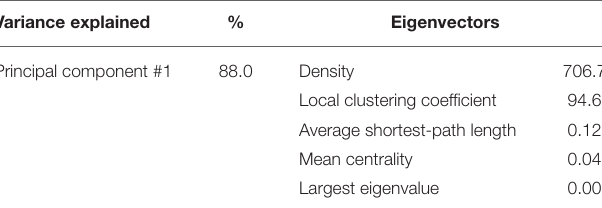
TABLE 2 | Total variance explained by the first principal component and loadings of its corresponding eigenvectors. Variance